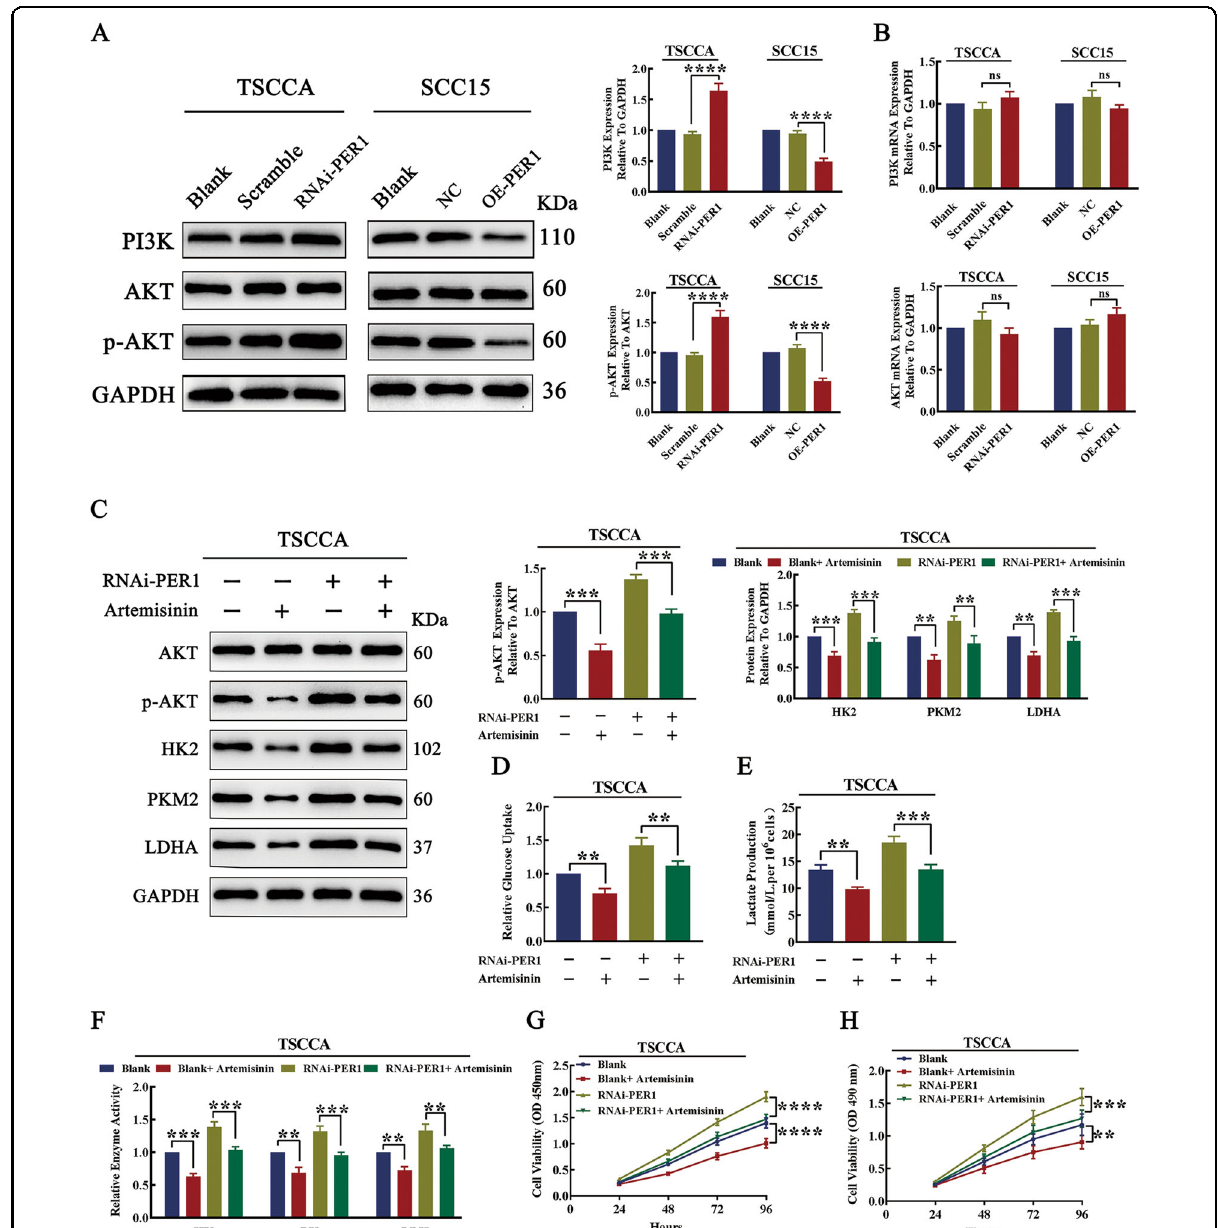
Fig. 4 PER1 regulated glycolysis and proliferation in OSCC cells in a PI3K/AKT pathway-dependent manner. A Western blot results showed that the levels of PI3K and p-AKT in RNAi-PER1-TSCCA cells were signi fi cantly increased, while the levels of PI3K and p-AKT were signi fi cantly decreased in OE-PER1-SCC15 cells. B RT-qPCR results showed that there were no signi fi cant changes in the mRNA levels of PI3K and AKT in RNAi- PER1-TSCCA and OE-PER1-SCC15 cells. C Western blot results showed that the increases in the levels of p-AKT, HK2, PKM2, and LDHA were signi fi cantly reversed after artemisinin was added to RNAi-PER1-TSCCA cells. D – F After artemisinin addition, the increases in glucose uptake, lactate production, and the enzymatic activity of HK, PK, and LDH in RNAi-PER1-TSCCA cells were signi fi cantly reversed. G , H The CCK-8 assay and MTT assay showed that the increased proliferation of RNAi-PER1-TSCCA cells was signi fi cantly reversed after artemisinin addition. All data are from three independent experiments. The data are presented as the mean ± SD values ( n ≥ 3). * P < 0.05; ** P < 0.01; *** P < 0.001; **** P <